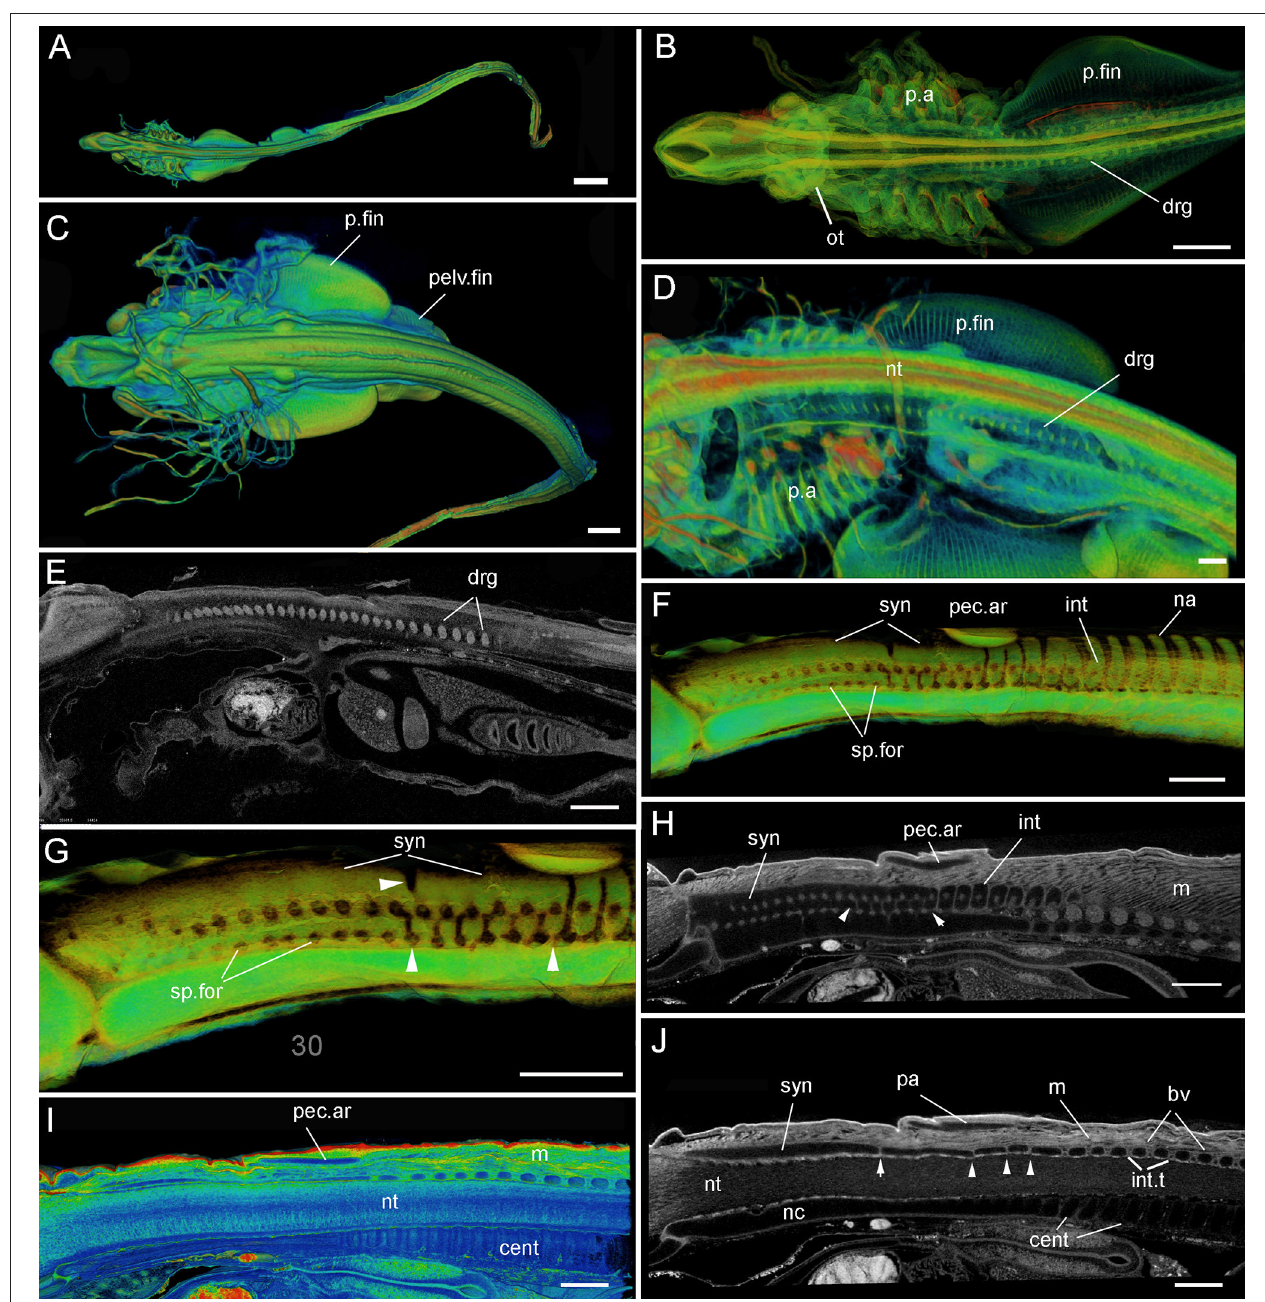
FIGURE 4 | Leucoraja erinacea , PTA staining, 3D rendered µ CT scans, false colored (A–D,F,G) grayscale (E, H, J) . (A, B) st. 24, Dorsal view of entire individual, (B) dorsal view including developing cranium, pharyngeal arches, pectoral fin; (C–E) st. 28 (BMNH 2018.9.26.5), (C) dorsal view of individual, (D) lateral view of developing pharyngeal arches, pectoral fin; (E) virtual sagittal section showing internal morphology; (F–J) st. 30 (BMNH 2018.9.26.4). (F,G) Posterior cranium, synarcual and more posterior vertebrae, white arrowheads indicate separation of vertebrae within synarcual; (H–J) virtual sagittal section showing internal morphology (cartilages as black spaces), (J) white arrowheads indicate separation of vertebrae within synarcual. Abbreviations as in Figures 1 – 3 , also: drg, dorsal spinal nerve root ganglia; int.t, intervertebral tissues; m, musculature; nc, notochord; ot, otic region; p.a, pharyngeal arches. Anterior to the left. Scale bars: (A,C) = 1mm; (B,D,E–J) = 500 um.